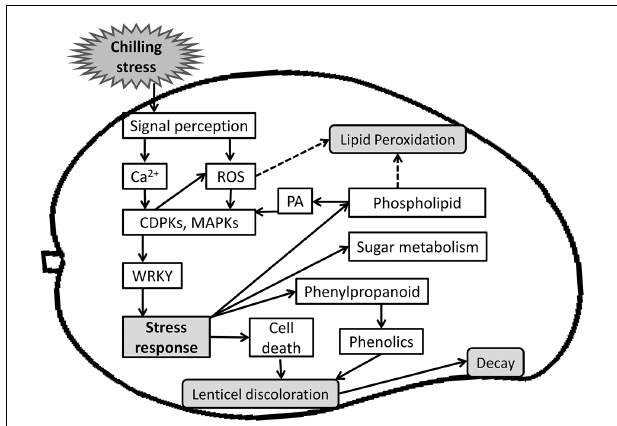
FIGURE 10 | A Scheme summarizing events of mango fruit response to storage at sub-optimal temperature. Upon storage at sub-optimal temperature, fruit sense the chilling stress and initiate cold stress signal transduction pathway. A cascade of signaling molecules (Ca 2 + , ROS) act as secondary messengers and activates several kinases (CDPK, MAPK), which activates transcription factors (WRKY) and further activate stress response. Ultimately, a wide range of stress responses were activated, such as phenylpropanoid pathway that produces phenols, which is transported from the resin-duct to the lenticel, and cell death that accumulate in the same lenticel lumen and is tightly correlated to the later increase in decay. Chilling stress response also activates sugar metabolism for osmolytes synthesis and phospholipid metabolism that leads to synthesis of PA, which is known to activate CDPK and MAPK signaling and stress response.